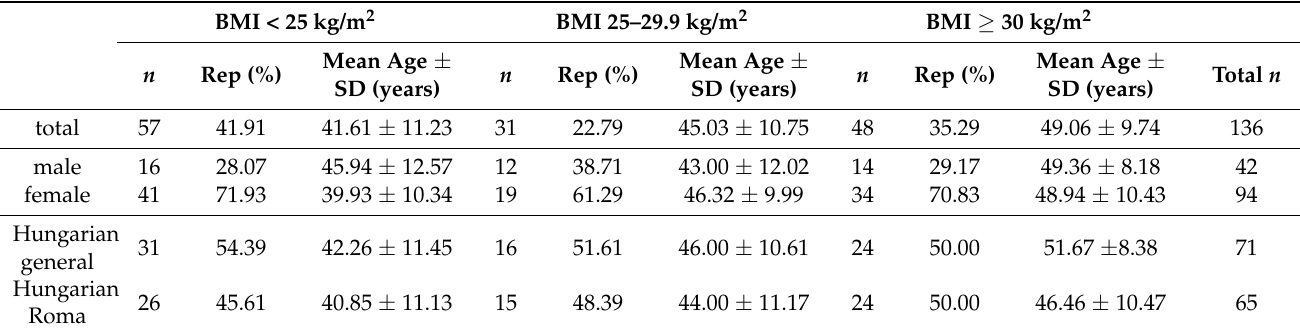
Table 1. Demographic and anthropometric parameters of the study